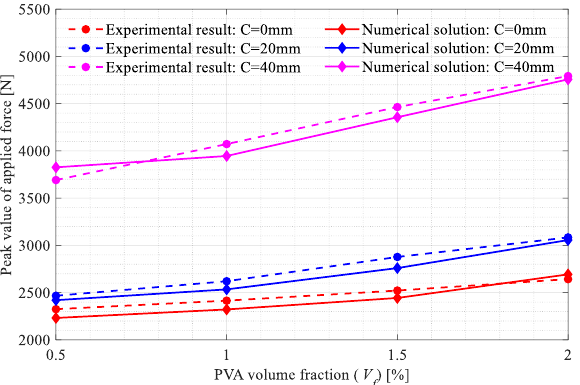
Figure 15. Variations in the peak force values in the simulations versus the volume fractions of PVA fibers in the